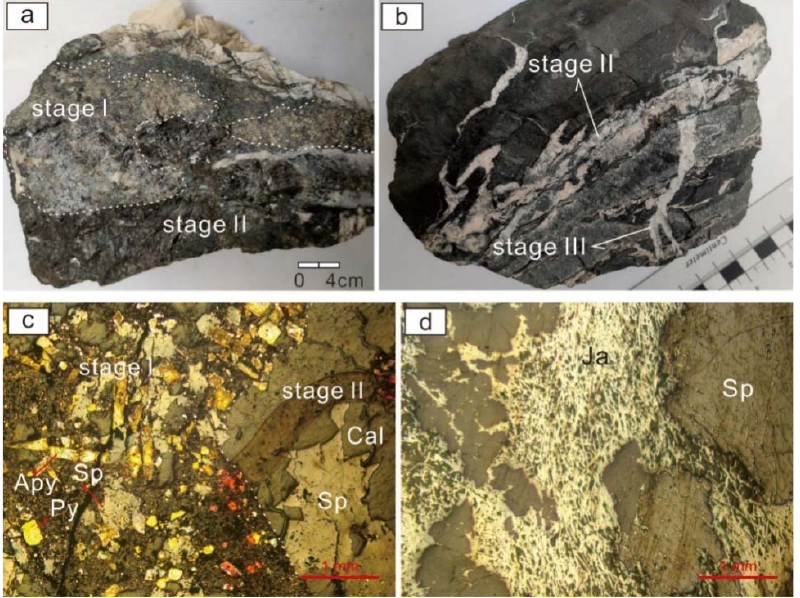
Figure 2. Photos showing the relationship among different stage mineralization. ( a ) Stage I mineralization is cut and enclosed by stage II mineralization. ( b ) Stage II mineralization is cut by stage III calcite-quartz vein. ( c ) Stage I mineralization consists of sphalerite, arsenopyrite and pyrite and stage II mineralization consists of sphalerite and calcite. ( d ) Jamesonite replaces or cut sphalerite in Stage II mineralization. Cal: calcite, Apy: arsenopyrite, Sp: sphalerite, Ja: